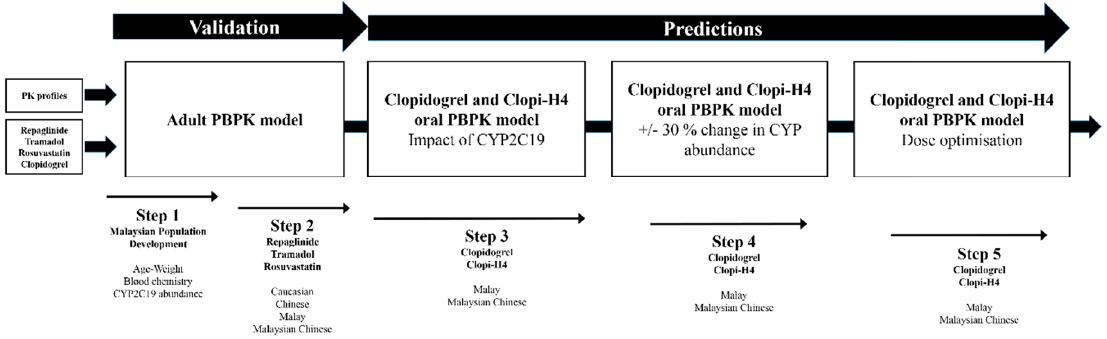
Figure 14. Model development strategy. The five-stage workflow approach implemented to study pharmacokinetics within Malaysian population groups.